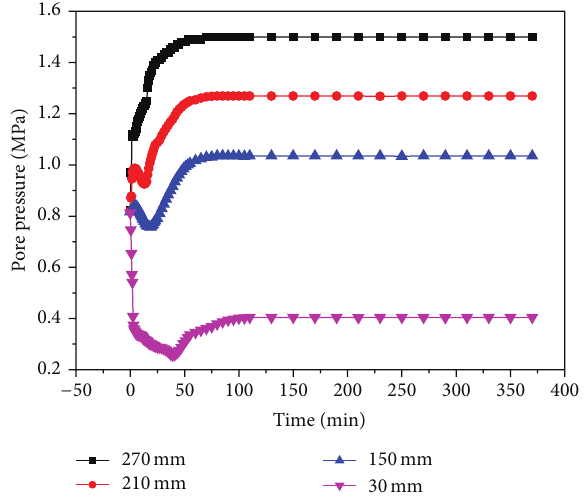
Figure 16: The change in pore pressure during CO 2 -ECBM at 1.5 MPa.